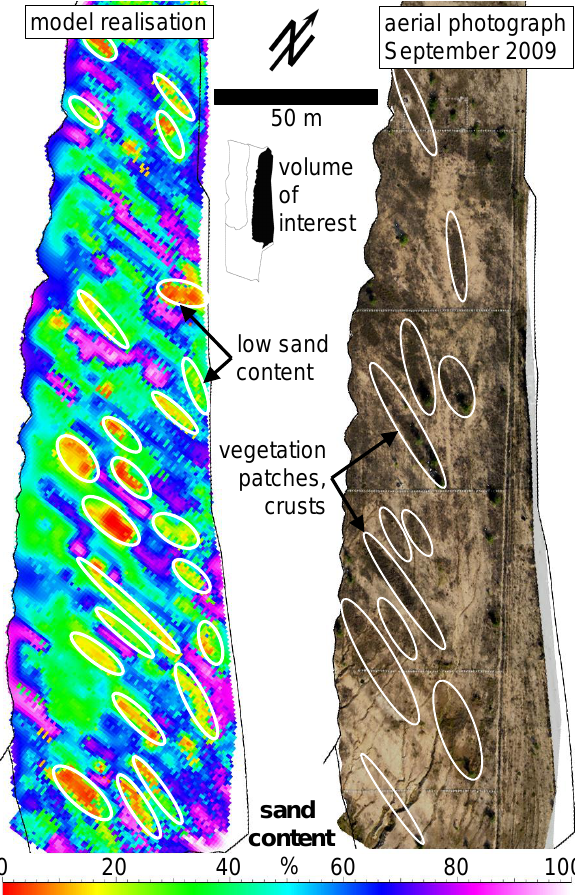
Fig. 11. Comparison of generated sediment heterogeneity patterns (left) and patterns on the eastern part of the artificial catchment asso- ciated with sediment heterogeneity (right). The ellipses mark zones with relatively low sand contents – and respectively high contents of silt and clay – on the left side, and zones with relatively dense vegetation cover and/or crusting on the right